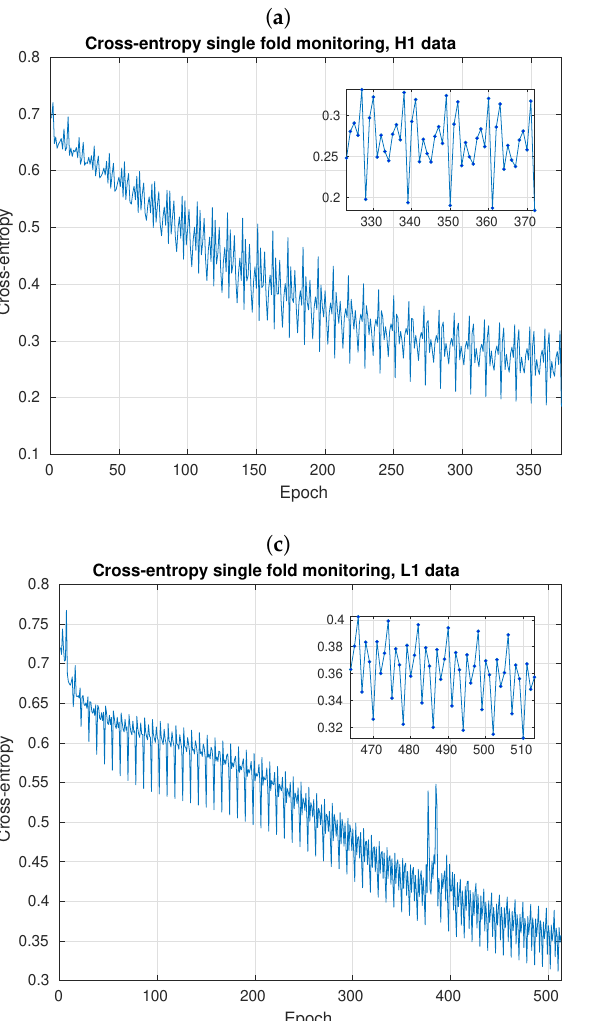
Figure 6. Evolution of cross-entropy (left panels: ( a , c )) and accuracy (right panels: ( b , d )), in the function of epochs of learning process, using data from H1 detector (upper panels) and L1 detector (lower panels). On trending, cross-entropy decreases and accuracy increases, even if there is a clear stochastic component due to the mini-batch SGD learning algorithm. Here we set length of sliding windows in T win = 0.50 s, and the CNN architecture with 2 stacks and 20 kernels. Some anomalous peaks appear when data from L1 detector is used, but this does not affect the general trends of mentioned